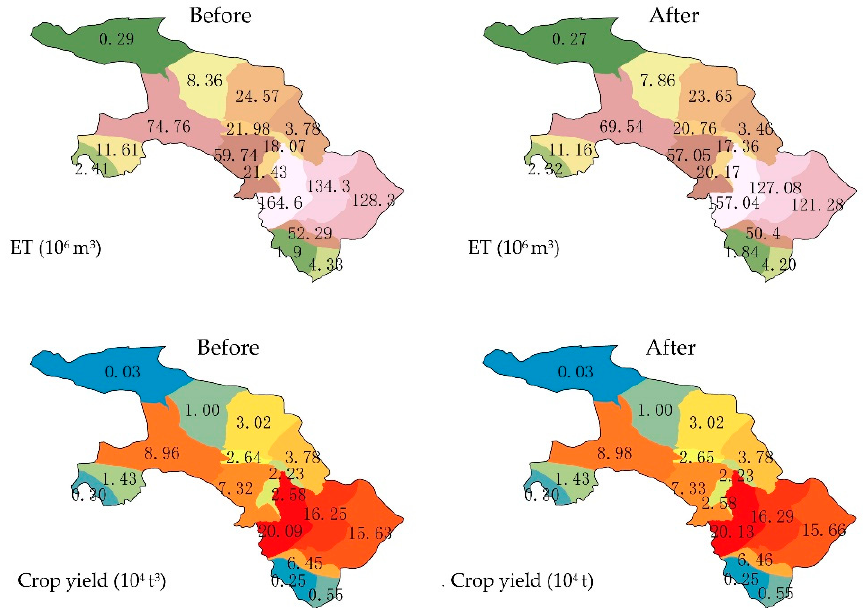
Figure 9. Annual evapotranspiration and crop yields of maize for different irrigation districts during 2001 to 2010 before and after irrigation optimization conditions.